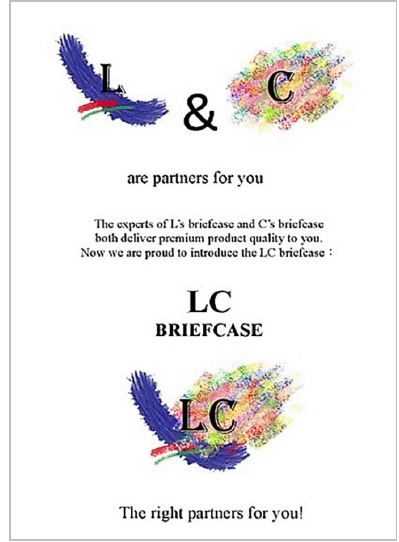
Fig. 6. The co-branding